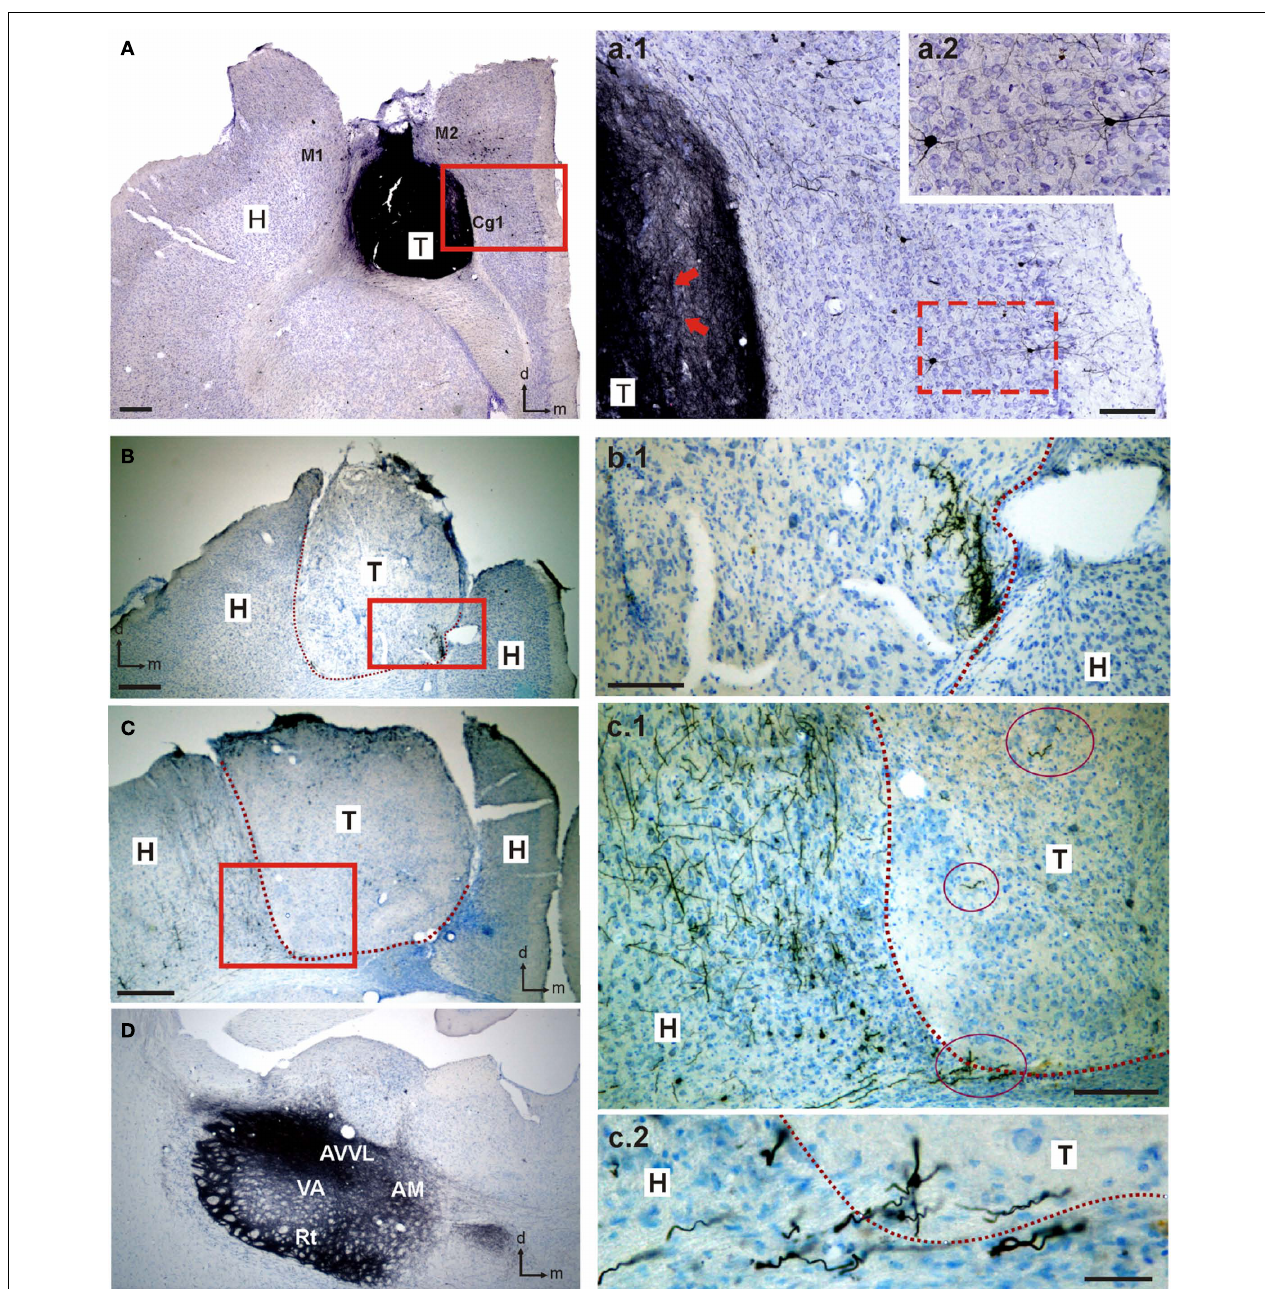
also be observed in (a.1) (red arrows). (B,C) Photomicrographs of coronal sections through two amygdalar transplants placed heterotopically in motor cortical location. Red squares shows BDA-labeled fibers in the host and the transplant at higher magnification (b.1,c.1) . Dashed lines indicate transplant-host interface. Red ovals in (c.1) indicate labeled fibers within the transplant or transplant edge. One of these fibers is illustrated at higher magnification in (c.2) . (D) . Photomicrograph of a coronal section through the BDA injection site in the thalamus. AVVL, anteroventral thalamic nucleus, ventral part; AM, anteromedial thalamic nucleus; Cg1, cingulated cortex, area 1; H, host; M1, primary motor cortex; M2, secondary motor cortex; Rt, reticular thalamic nucleus;T, transplant;VA, ventral anterior thalamic nucleus. Scale bars, (A–C) : 250 μ m; (a.1,b.1,c.1) : 100 μ m; (c.2) : 20 μ